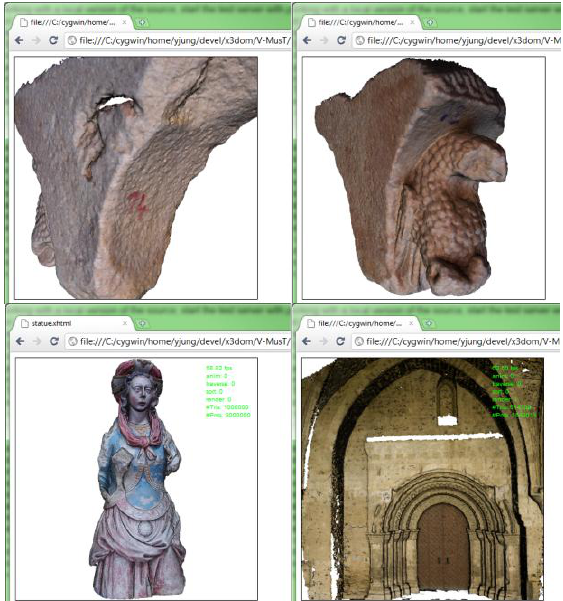
Figure 7. Virtual Heritage objects visualized with X3DOM. Top row: a reconstructed 3D capitel of an abbey that can be freely examined from all directions. Bottom row: the statue to the left is a 63 MB 3D scan and the front of the church shown to the right has 32 MB of vertex data.